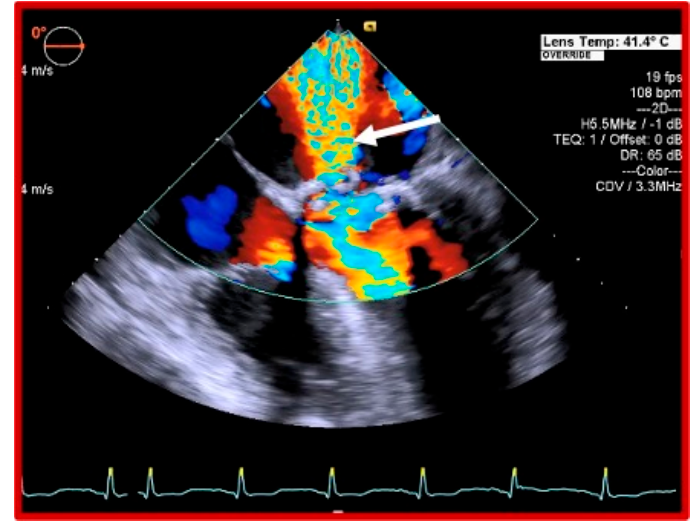
Figure 2. Doppler two-dimensional (2D) transesophageal ECHO showing a large mitral regurgitant jet.